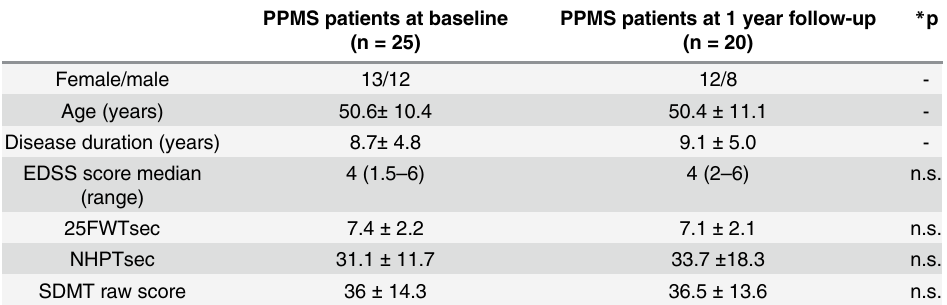
Values in table are: mean +/- standard deviation; PPMS = primary progressive multiple sclerosis; EDSS = Expanded Disability Status Scale; 25FWT = 25 Feet Walk Test; NHPT = Nine Hole Peg Test; SDMT = Symbol Digit Modality